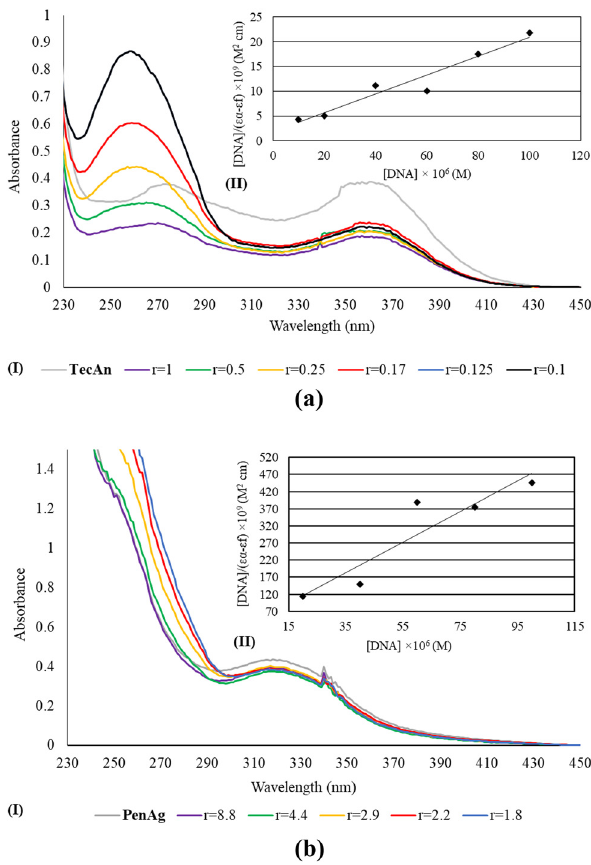
Figure 9: ( I ) UV spectra of TecAn ( a ) and PenAcAg ( b ) in the absence and presence of CT DNA at r values 1, 0.5, 0.25, 0.17, 0.125, and 0.1 for TecAn and8.8,4.4,2.9,2.2,and1.8for PenAcAg ( r =[ complex ] / [ DNA ] ,